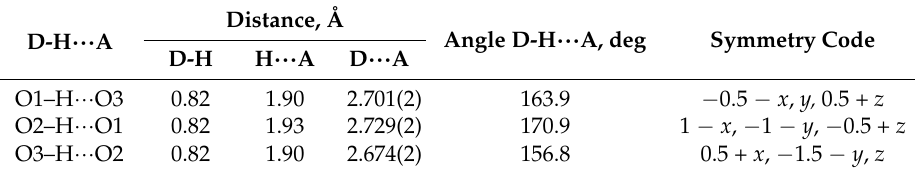
Table 2. H-bond parameters for compound 8 .